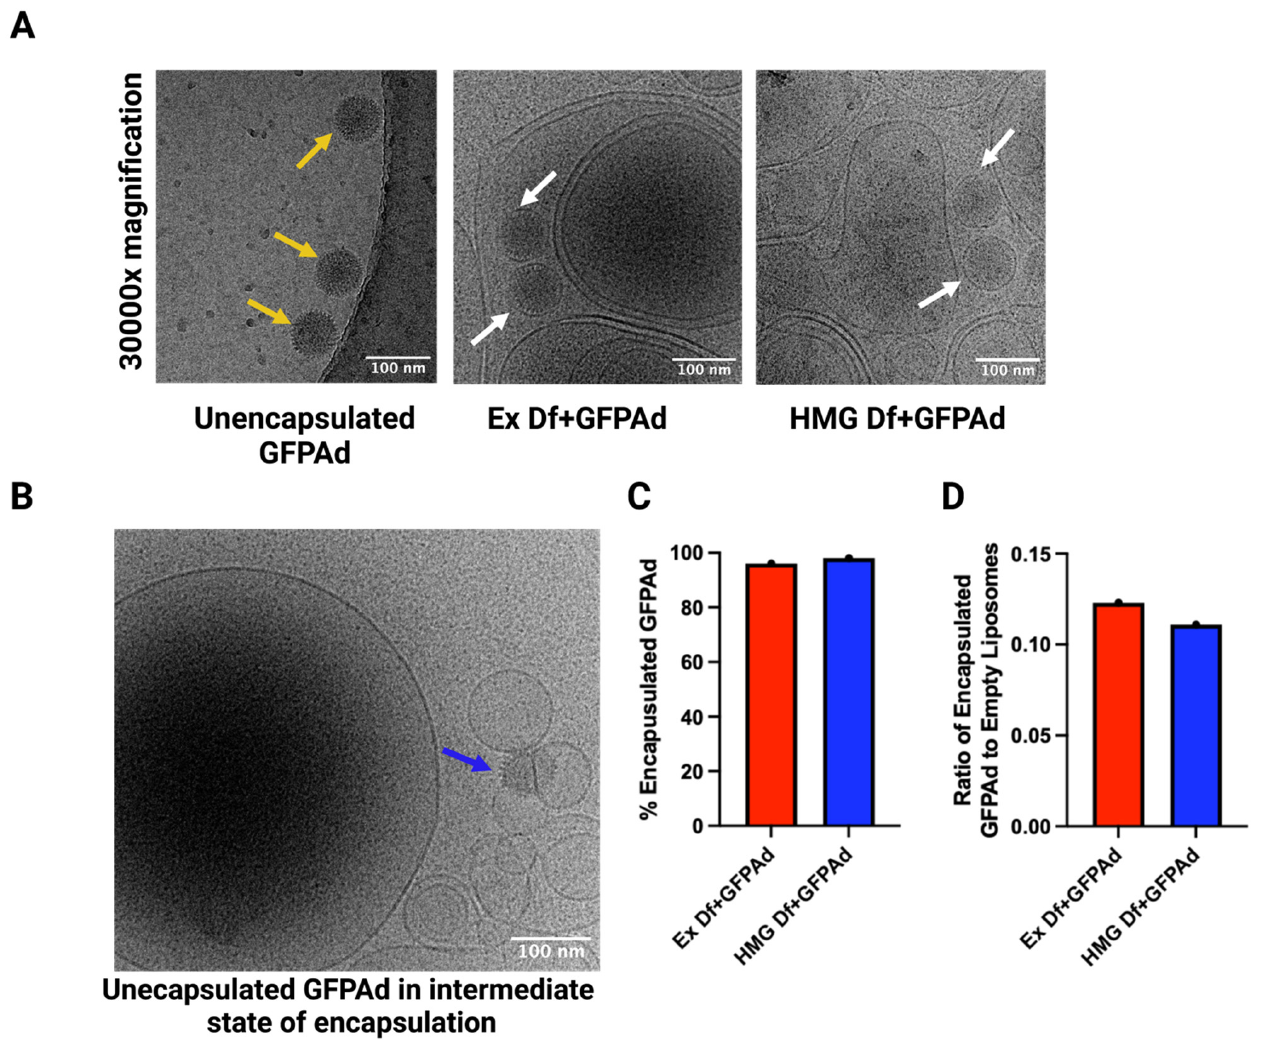
Figure 5. Cryo-EM images of Ad liposomes and unencapsulated Ad: ( A ) Cryo-EM images of unencapsulated GFPAd, Ex Df + GFPAd, and HMG Df + GFPAd at 30000 × magnification. Yellow arrows highlight unencapsulated GFPAd without lipid encapsulation and white arrows highlight spherical lipid encapsulation around GFPAd in GFPAd liposomes. ( B ) Cryo-EM image demonstrating intermediate state of virus encapsulation. Blue arrow highlights the unencapsulated GFPAd in intermediate state of encapsulation. All scale bars represent 100 nm. ( C ) % Encapsulation efficiency of GFPAd in Ex Df + GFPAd (red bar = 96%) and HMG Df + GFPAd (blue bar = 98%). ( D ) Ratio of encapsulated GFPAd to empty liposomes in Ex Df + GFPAd (red bar = 0.12) and HMG Df + GFPAd (blue bar = 0.11).